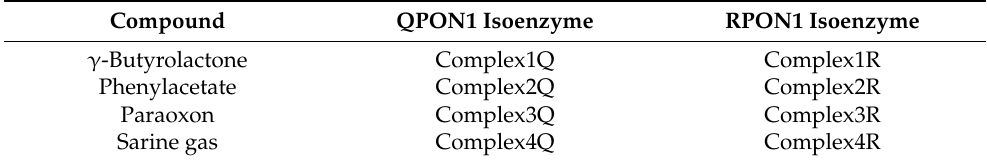
Table 3. Selected substrates and nomenclature of enzyme substrate complexes.